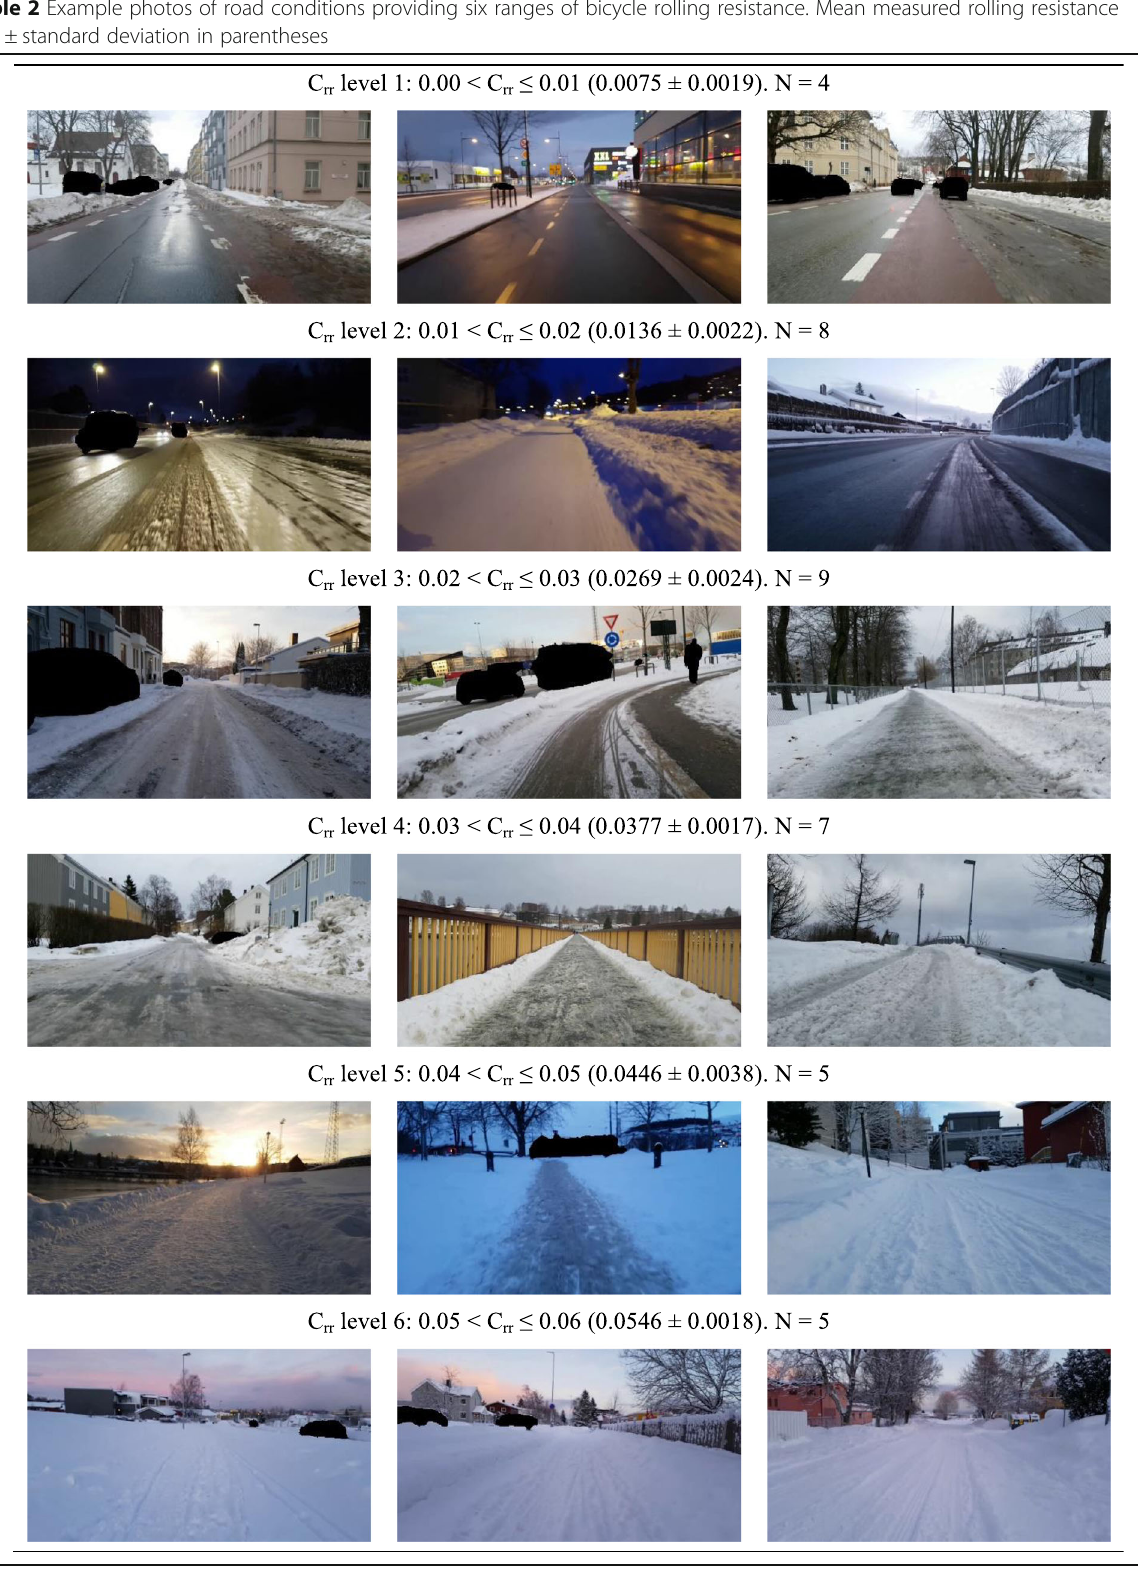
Table 2 Example photos of road conditions providing six ranges of bicycle rolling resistance. Mean measured rolling resistance and ± standard deviation in